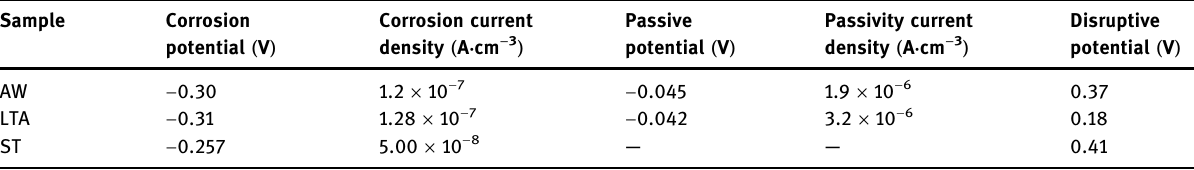
Table 5: Corrosion electrochemical parameters of welded joints